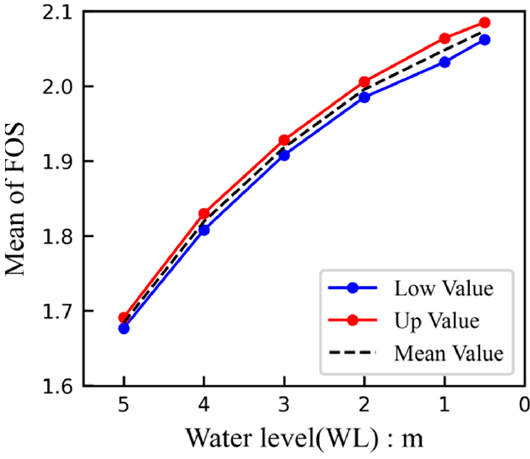
Figure 8. The results of deterministic analysis.